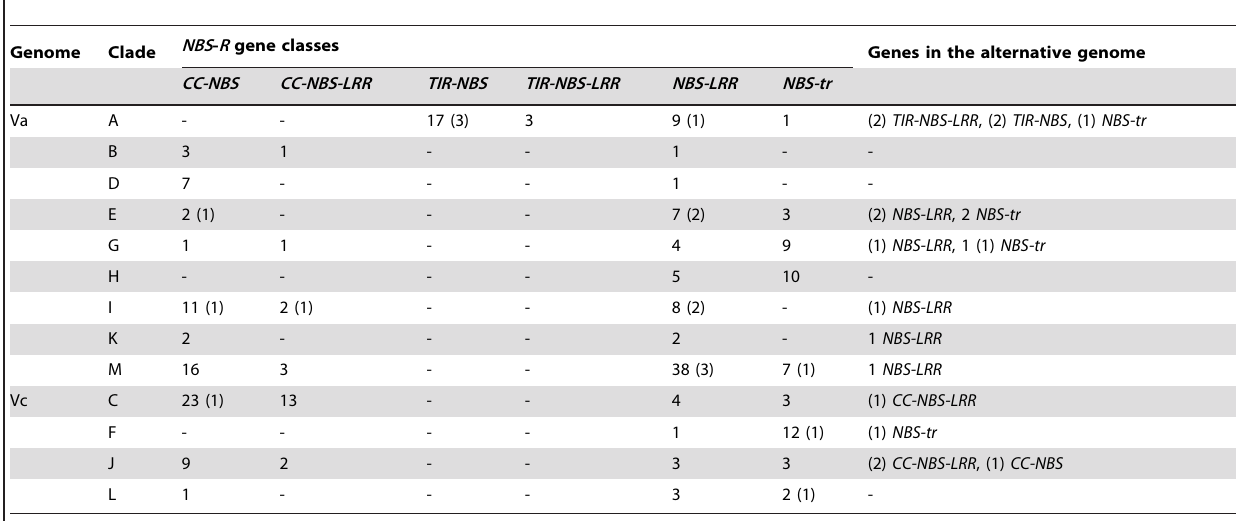
Table 1. Presence of clustered and single (in brackets) NBS - R genes in putative Va and Vc component genomes.